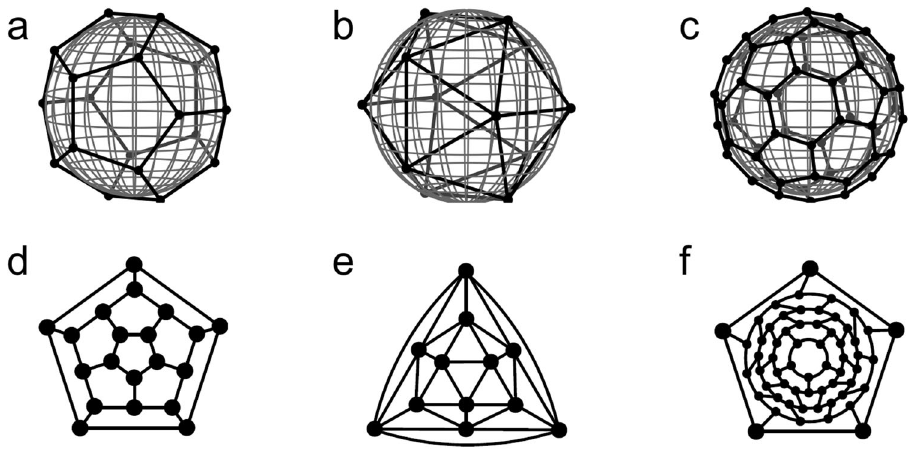
Fig. 2 Dispersed agent con fi gurations and their corresponding graphs. a – c Points and bold lines represent the vertices and the edges in the graphs, respectively. The network con fi gurations on the sphere S 2 correspond to Platonic solids a dodecahedron and b icosahedron. The geometrical con fi guration of Buckminsterfullerene molecules in c corresponds to the Archimedean solid truncated icosahedron. These con fi gurations are obtained when the coupling parameters k ij ∈ {0, K }, i.e., the coupling is uniform apart from its dependence on the network, and the network structure is given by the graphs in d – f . When the graph is given by one of d – f and the agents are in the corresponding dispersed con fi guration in a – c , then this is an unstable equilibrium of the homogeneous Kuramoto model Eq.